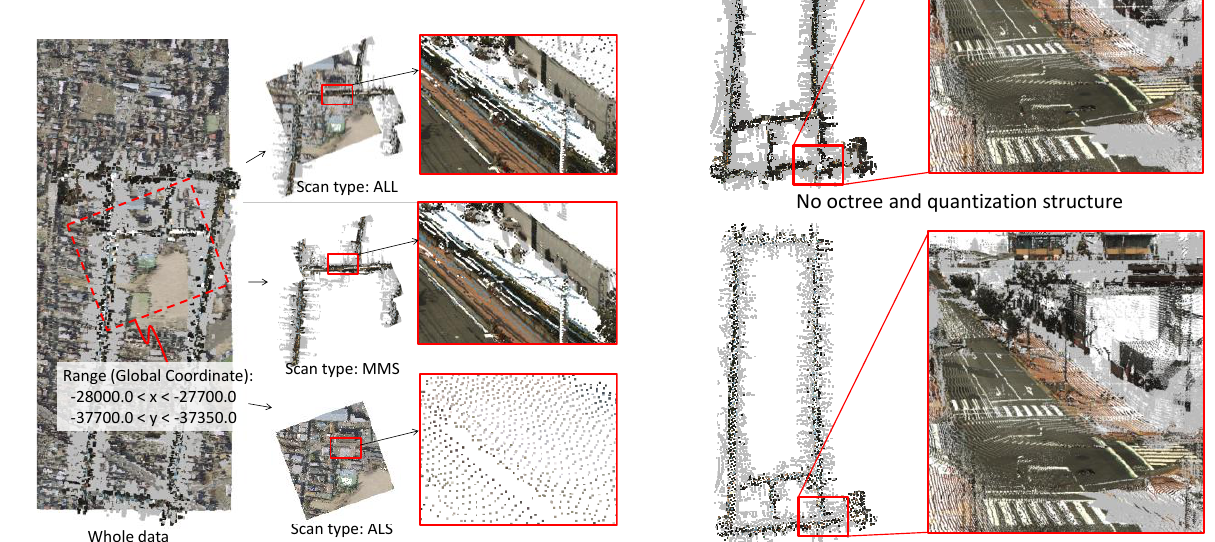
Figure 8. Result of point cloud